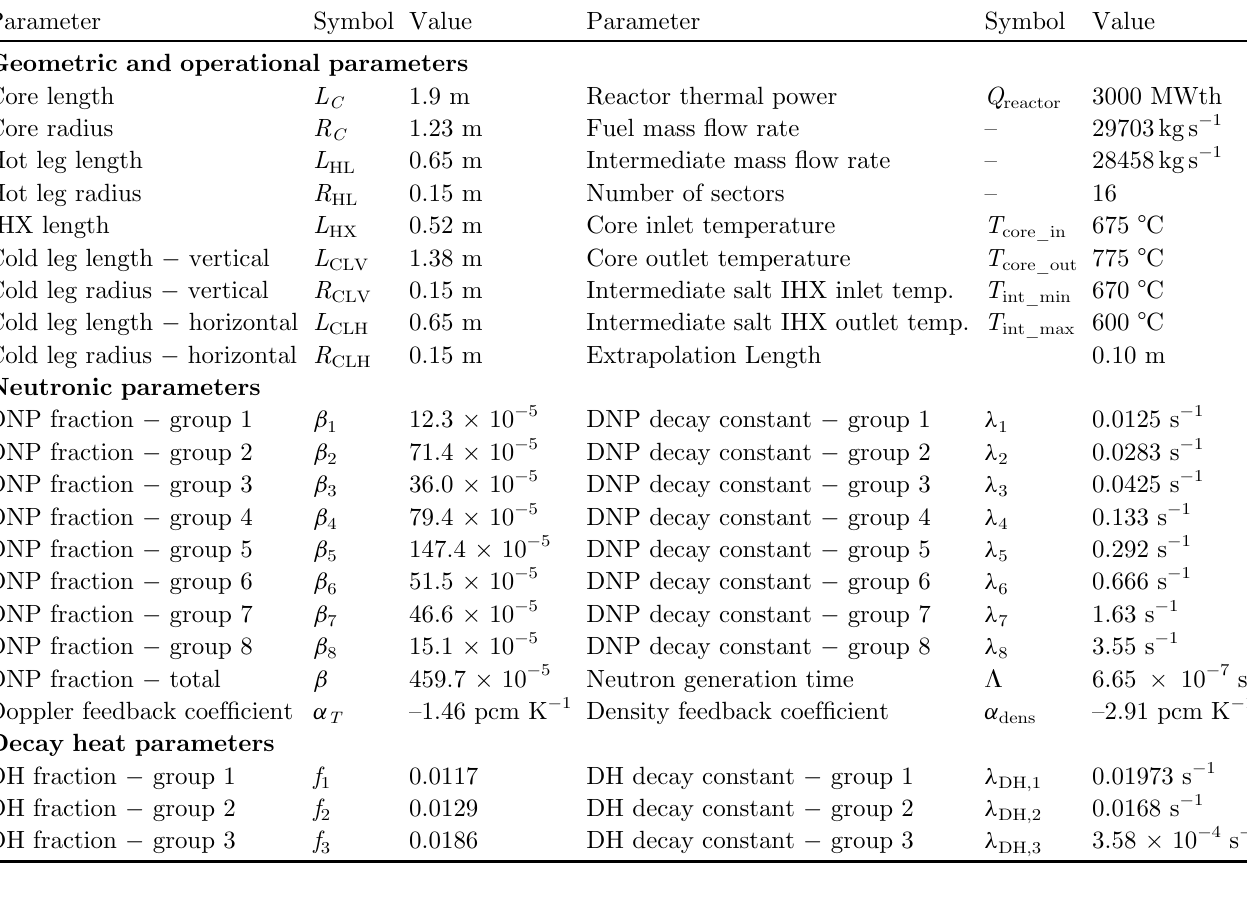
Table 2. MSFR geometric, operational and physical